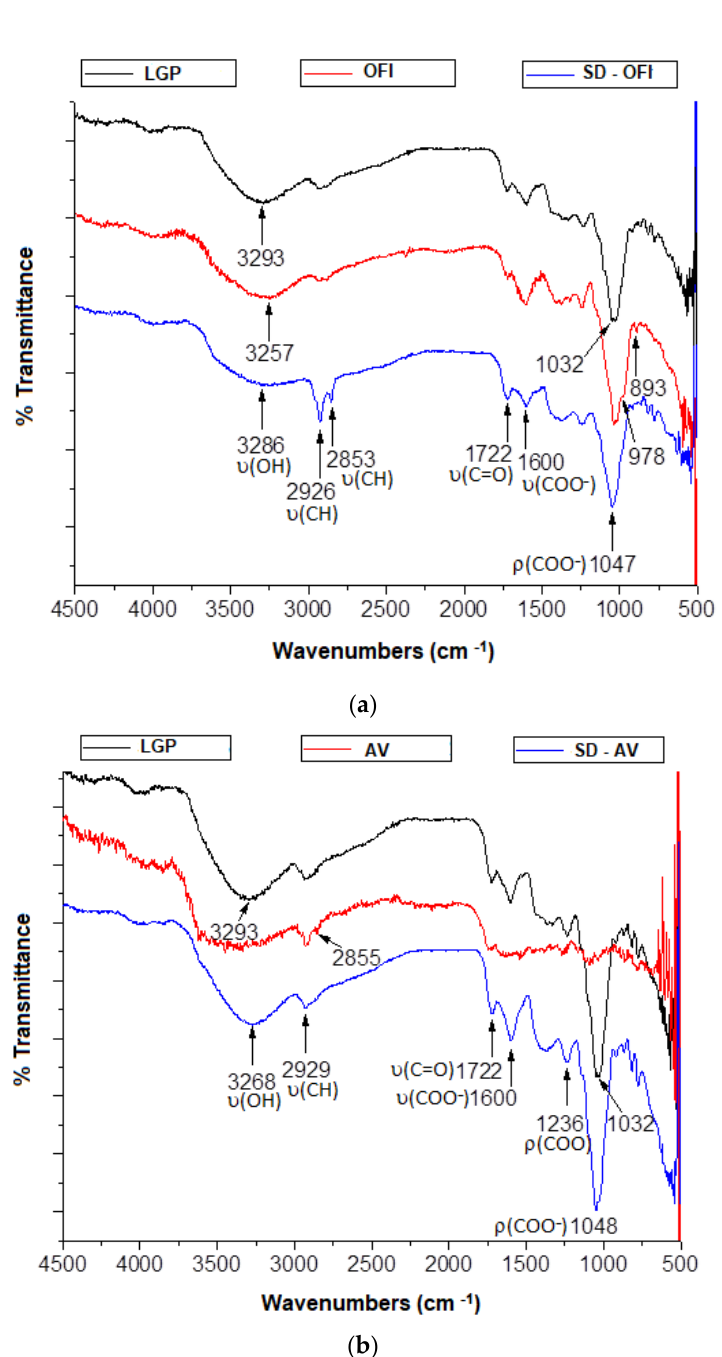
Figure 2. FTIR spectra of lyophilized guava pulp (LGP), mucilages (( a ) OFI and ( b ) AV) and micro- capsules (SD-OFI and SD-AV).